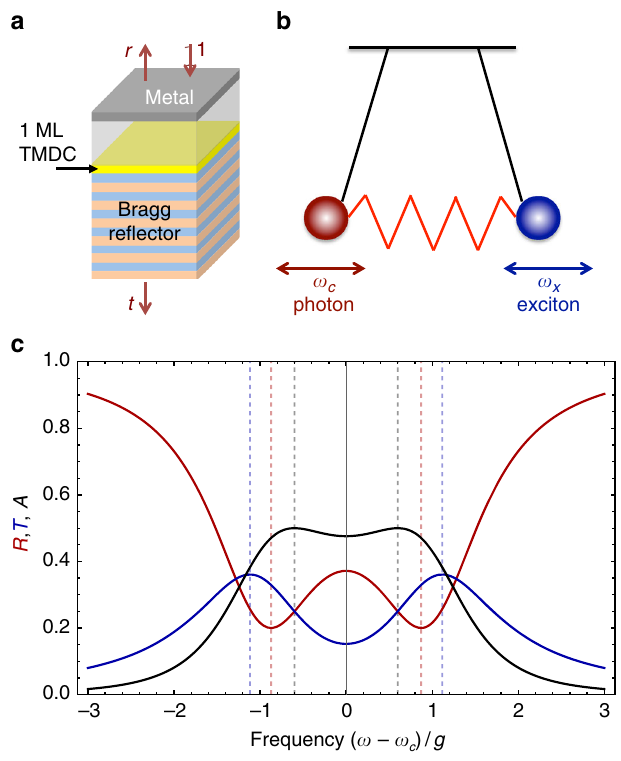
Fig. 2 Basic concept of strong coupling. a Sketch of the TMDC ML in an optical microcavity fabricated using a distributed Bragg re fl ector (bottom layers) and a metallic layer on top. b Illustration of the coupled-oscillators model describing the coherent energy transfer between the cavity photon and exciton. c Re fl ection ( R = | r | 2 , red curve), transmission ( T = | t | 2 , blue curve) and absorption ( A = 1 − R − T , black curve) coef fi cients calculated for the structure in a for the strong-coupling parameters ω c = ω x and κ ¼ γ ¼ 0 : 8